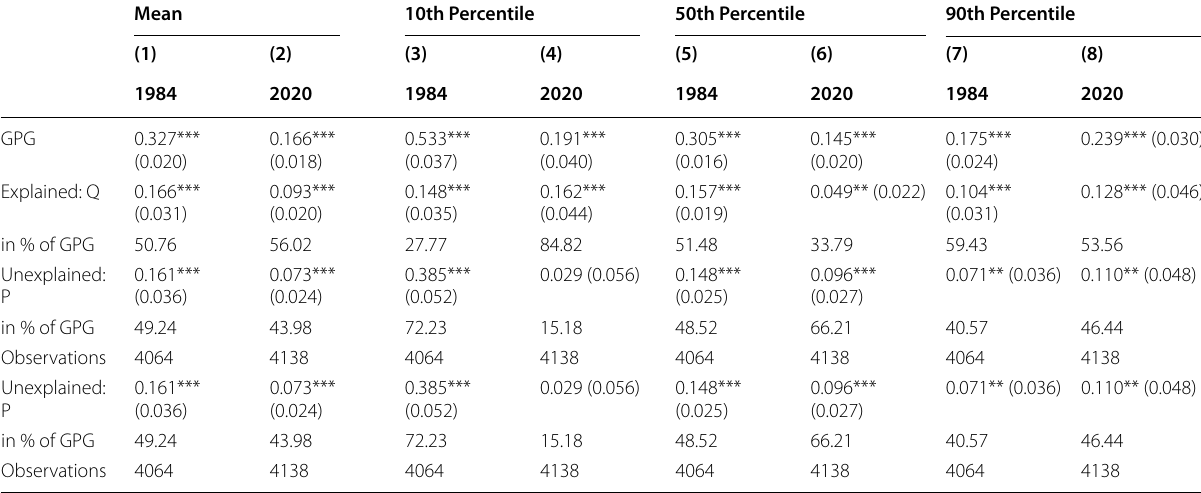
Table shows aggregate Oaxaca–Blinder decompositions of the Gender Pay Gap (GPG) in West Germany. Men are used as reference category. The regressions include quadratic polynomials of full‑time experience, job tenure, past part‑time experience (controls in years), as well as dummies for highest educational attainment, age, marital status, migration background, having at least one child, having at least one child below the age of two and between 2 and 6 years, respectively. Further, the following dummies are included: occupations (ISCO‑88, 1‑digit) and industries (NACE, level 1), small ( < 200 employees) and medium ( 200 and public‑sector firm. Federal state fixed effects included. Robust (for the mean) and bootstrapped (for the estimates beyond the mean, 500 replications) standard errors in